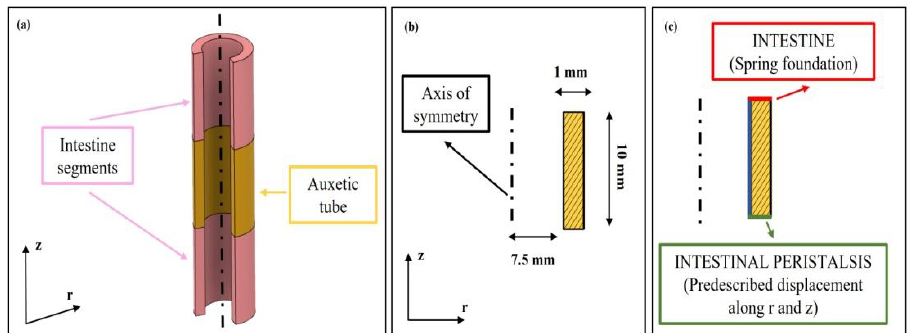
Figure 1. FE models of the silicone tube with different Poisson coefficients. ( a ) 3D representation of the modeled tube: the auxetic tube is interposed between two intestinal porcine segments. In the software, the tube was included as domain, whereas the property and movements of the intestines were included via boundary conditions. ( b ) Geometrical properties of the modelled silicone tube. ( c ) The green and red lines represent the imposed boundary conditions, whereas the blue line shows the boundary at which the quantities of interests were evaluated.